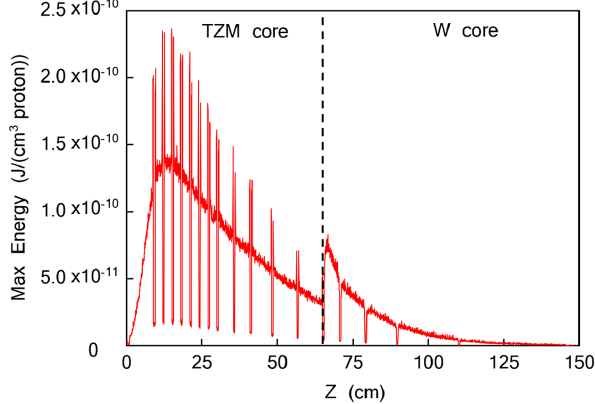
FIG. 2. Maximum deposited energy density per proton in the BDF target blocks along the longitudinal axis, obtained via FLUKA Monte Carlo simulations